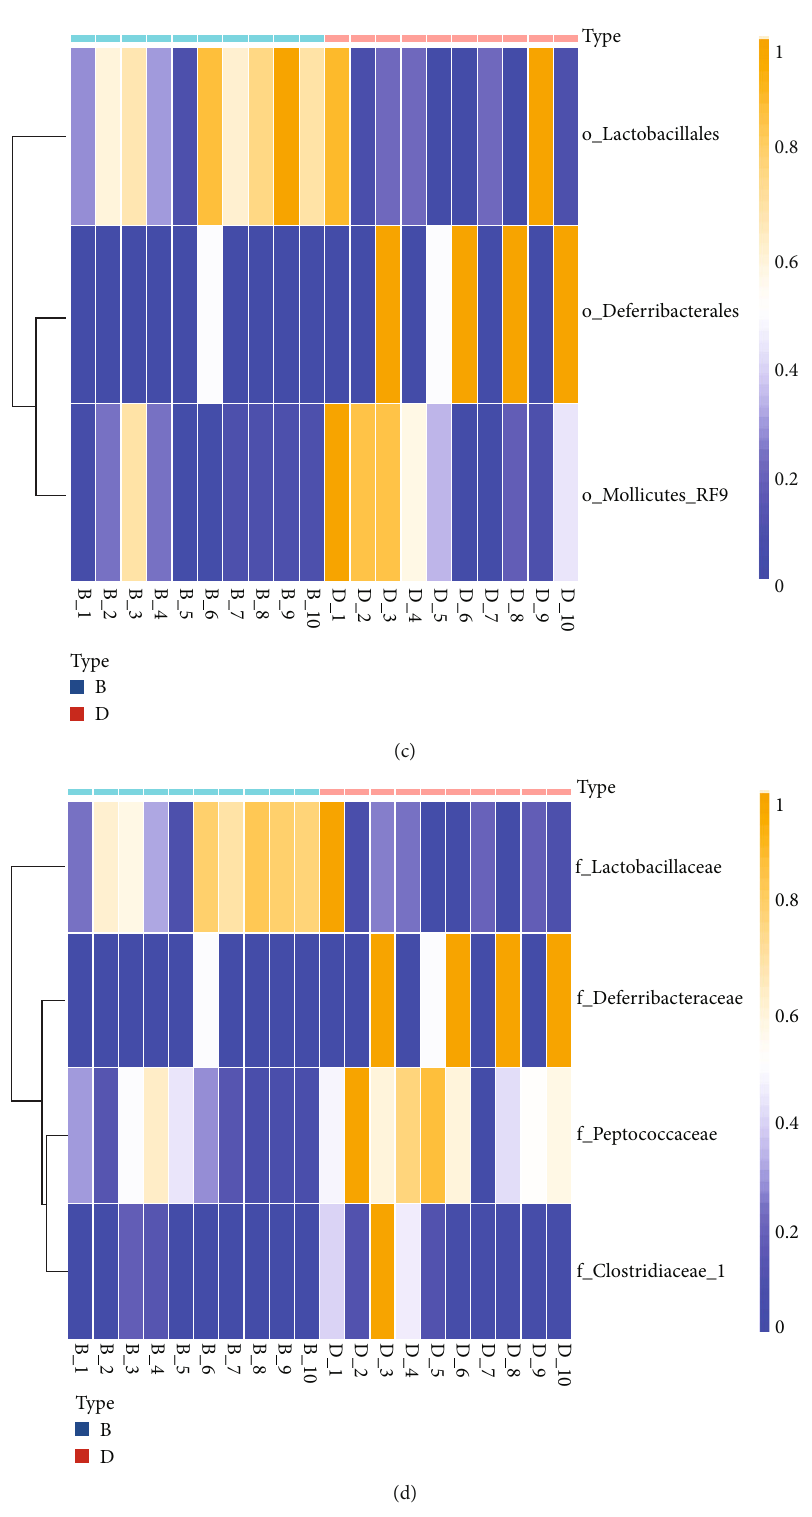
Figure 4: Heatmap of di ff erent taxonomic levels of microbiota under Wilcoxon ’ s test. (a – d) Relative abundance of bacterial community showed in heatmap in fecal samples at phylum to family levels (p: phylum; c: class; o: order; f: lales was decreased after treatment. At the family level was decreased after treatment. At the order level (Figure 3(d), Wilcoxon ’ s test, P < 0 : 05 ), Deferribacteraceae, (Figure 4(c), Wilcoxon ’ s test, P < 0 : 05 ), Mollicutes_RF9 Peptococcaceae, and Clostridiaceae_1 were increased while and Deferribacterales were increased while the Lactobacil-